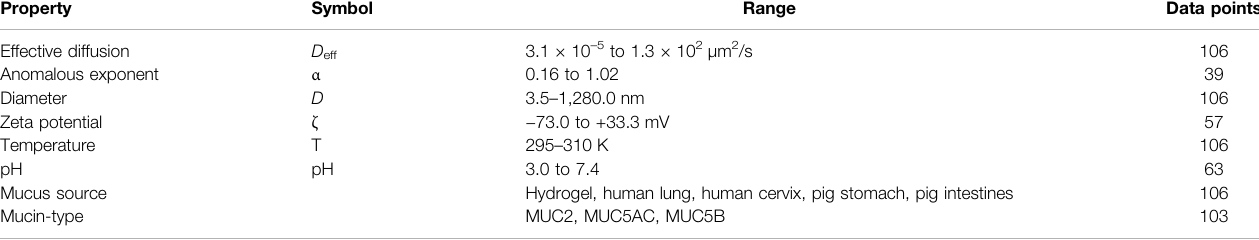
TABLE 1 | Summary of empirical data. The effective diffusion, D eff , was obtained for a common time window of 1 s. Property